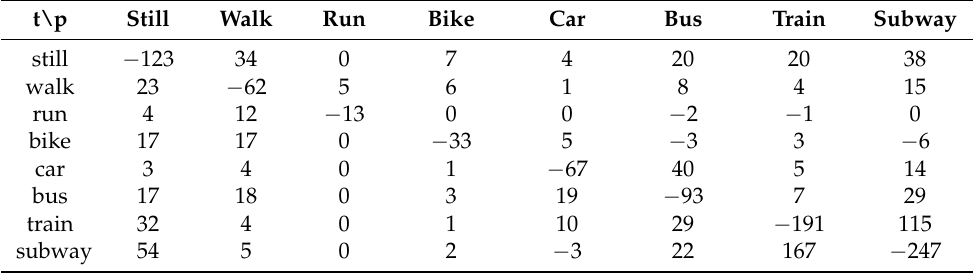
Table 10. The difference confusion matrix of the network trained without the pressure sensor. The largest loss in classification occurred in the class subway and the smallest in class run . t = true label, p = predicted